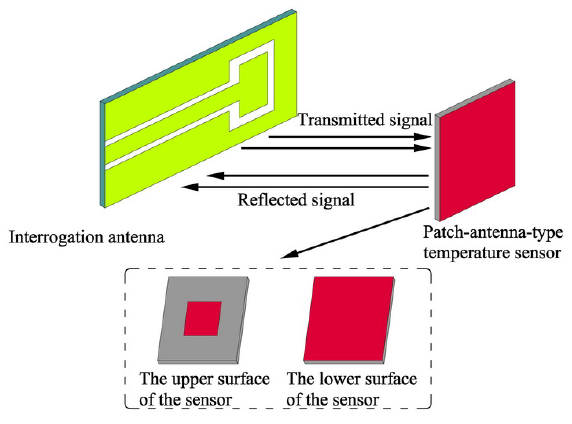
Figure 1. Schematic diagram of the patch antenna temperature sensor system.